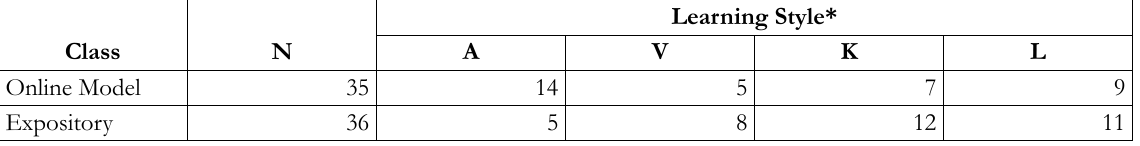
Table 7. Number of Students on Both Classes According to Learning Style